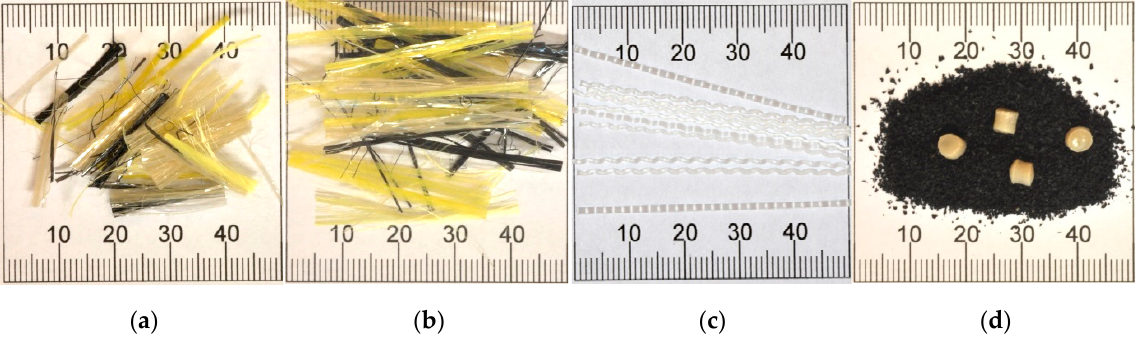
Figure 3. The additives used in the tests: ( a ) 19-mm-long aramid fibres; ( b ) 38-mm-long aramid fibres; ( c ) 50-mm-long polymer fibres, and ( d ) crumb rubber and polyoctynamer polymer modification applied to bitumen.